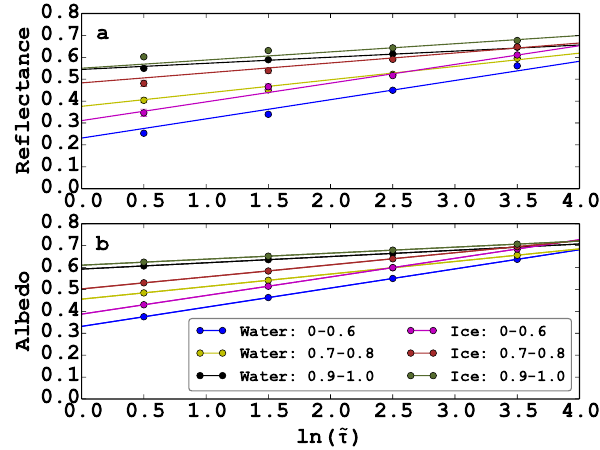
Figure 14. (a) Mean CERES reflectance values against ln ˜ τ for different cloud phases and mean η values for θ 0 = 55–60 ◦ , θ = 35– 40 ◦ , and φ = 45–50 ◦ . The fitted linear regression lines are also shown. (b) The albedo values against ln e τ for different cloud phases and mean η values and the fitted